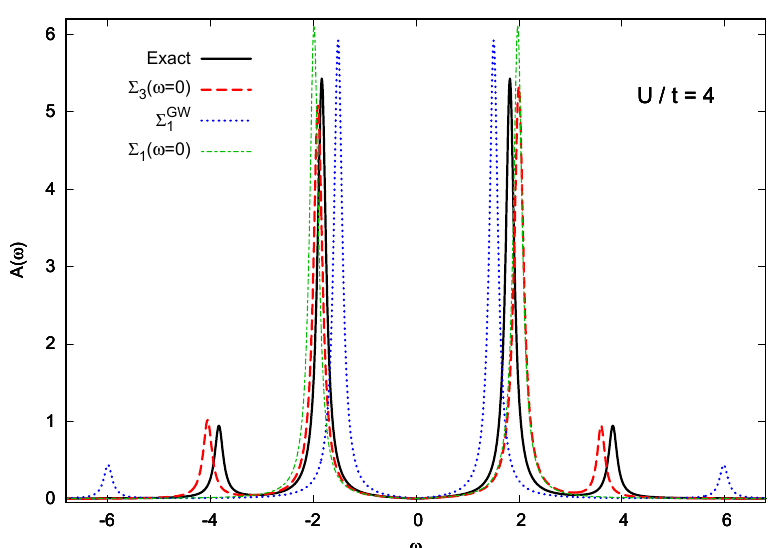
Figure 5: The spectral function of the Hubbard dimer at 1/2 filling at strong interaction ( U / t = 4 ) obtained with various levels of theory. Exact result (black solid line); the 1-GF obtained from the exact static 3-SE (red dashed line); the GW approximation (blue dotted line); the exact static 1-GF (green dashed line). The outer peaks are the satellites. The spectra correspond to ε guarantees the particle-hole